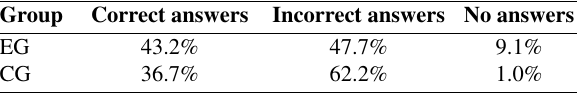
Table 2. Formation 2-chlorobutane, percentages of correct and in- correct answers.